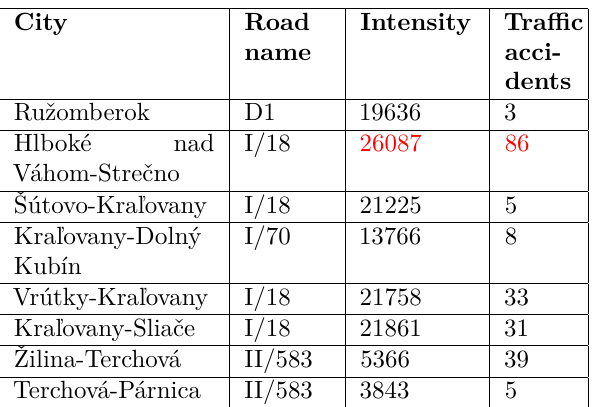
Table 1. Traffic accident rates on the selected sections of road network in